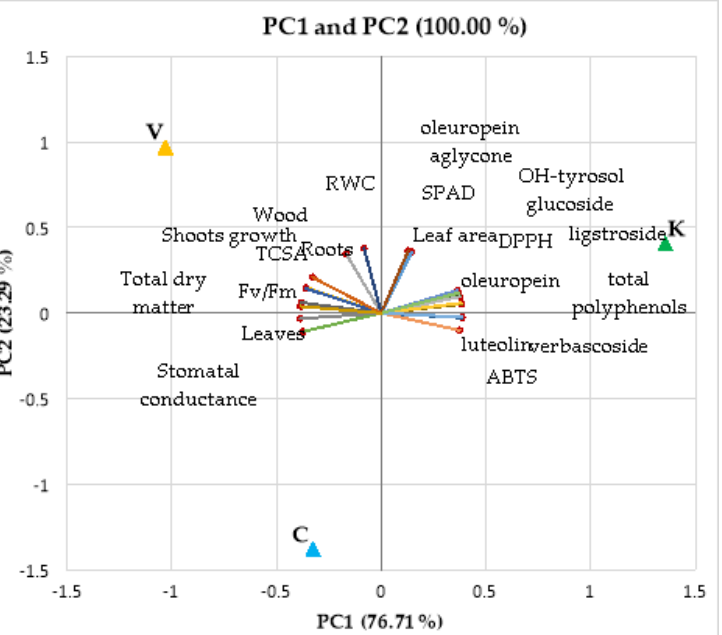
Figure 6. Principal component analysis (PCA) of biometric parameters (shoots growth, TCSA (trunk cross-sectional area), leaf area and dry matter of roots, wood, leaves and total dry matter), physiological parameters (stomatal conductance, RWC, SPAD and F v /F m ), nutraceutical parameters (OH-tyrosol glucoside, verbascoside, oleuropein, ligstroside, luteolin, oleuropein aglycone, total polyphenols, ABTS and DPPH), under the application of two anti-transpirants K: kaoline and V: di-1-p-menthene in comparison to C: control. For the PCA, the parameters of stomatal conductance, RWC and SPAD analyzed were those of August, and for F v /F m those of 2:00 pm (the values obtained after prolonged thermal stress were considered).